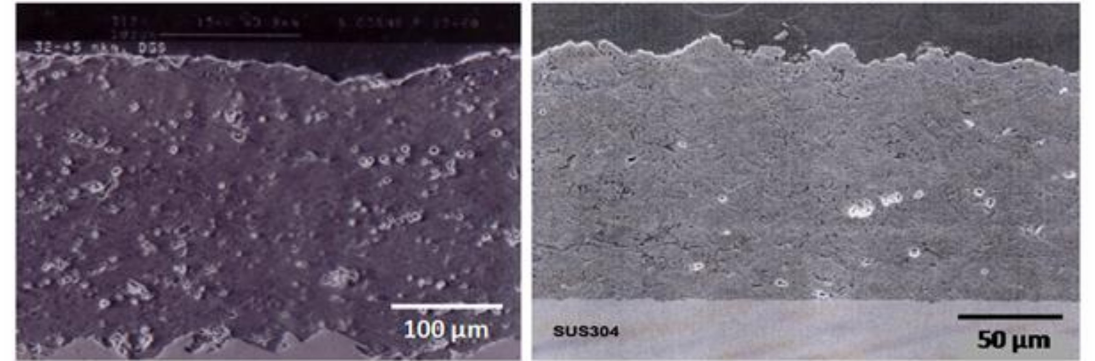
Figure 3. Silicon nitride-based coatings on austenitic stainless steel produced by detonation spraying (left) and ultrahigh velocity pulsed plasma spraying (right) [12]. © With permission from